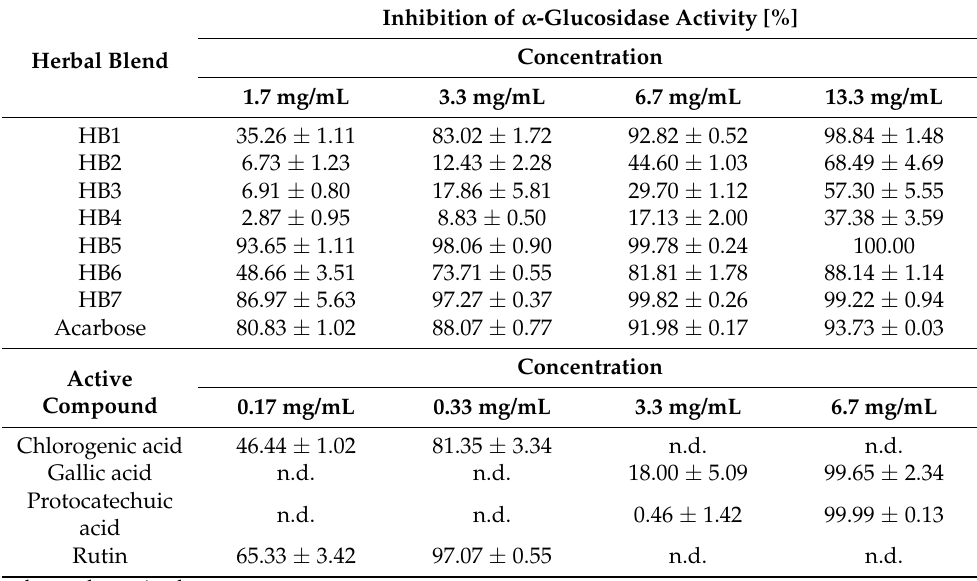
Table 4. Inhibition of α -glucosidase activity by the infusions from herbal blends.